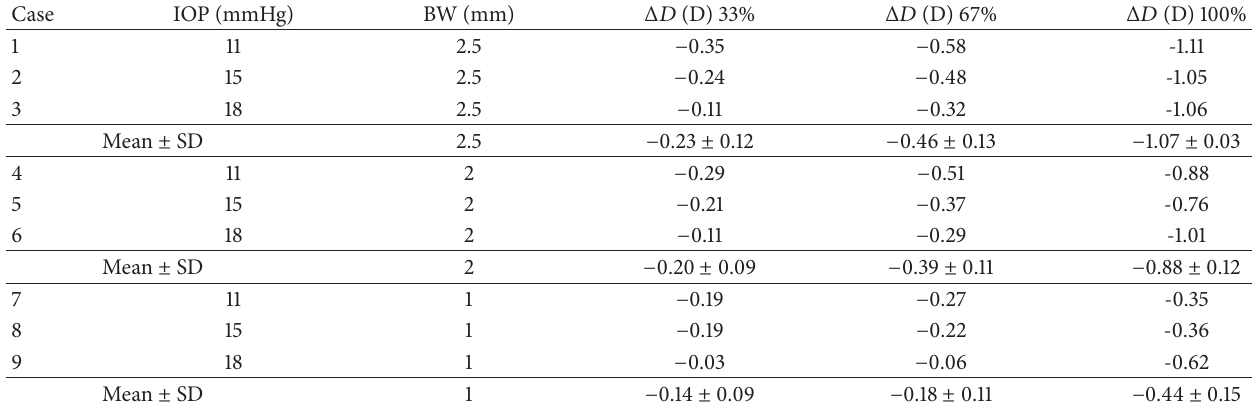
Table 3: Increment of myopia ( Δ𝐷 ) in diopters (D) induced by the scleral buckling surgery in the numerical model for the nine cases considered (bandwidths of 1, 2, and 2.5 mm; IOP of 11, 15, and 18mmHg) at three different levels of tightening (33%, 67%, and 100%). Since no relation is observed with IOP, the mean value of the myopia induced for each of the three bandwidths is also shown.